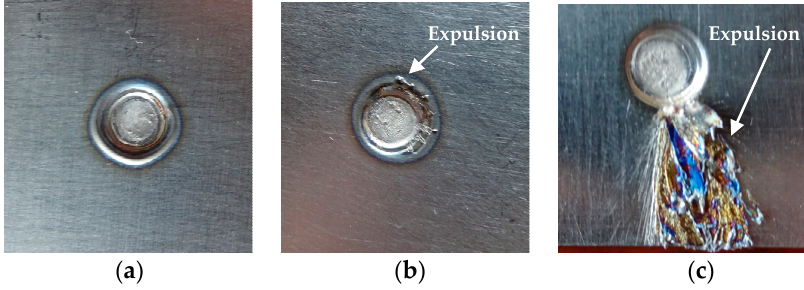
Figure 3. Appearances of resistance spot welded joints with different welding currents: ( a ) 9 kA; ( b ) 10 kA; and ( c ) 12 kA.